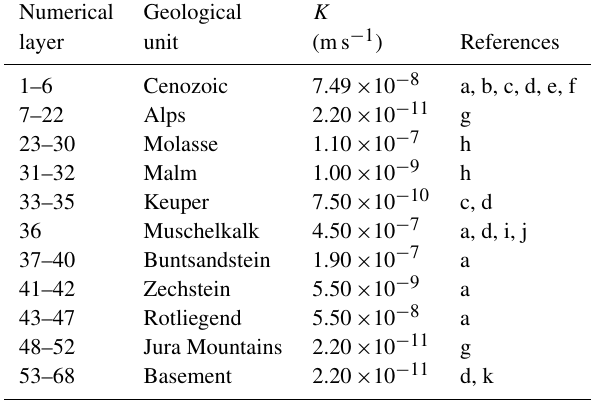
Table 1. Physical input property hydraulic conductivity ( K ; ms − 1 ) for each geological unit. Values derived from (a) Bär (2012), (b) Lampe and Person (2002), (c) Jodocy and Stober (2011), (d) GeORG-Projektteam (2013a), (e) Clauser and Villinger (1990), (f) Stober and Bucher (2015), (g) LfU (2007), (h)